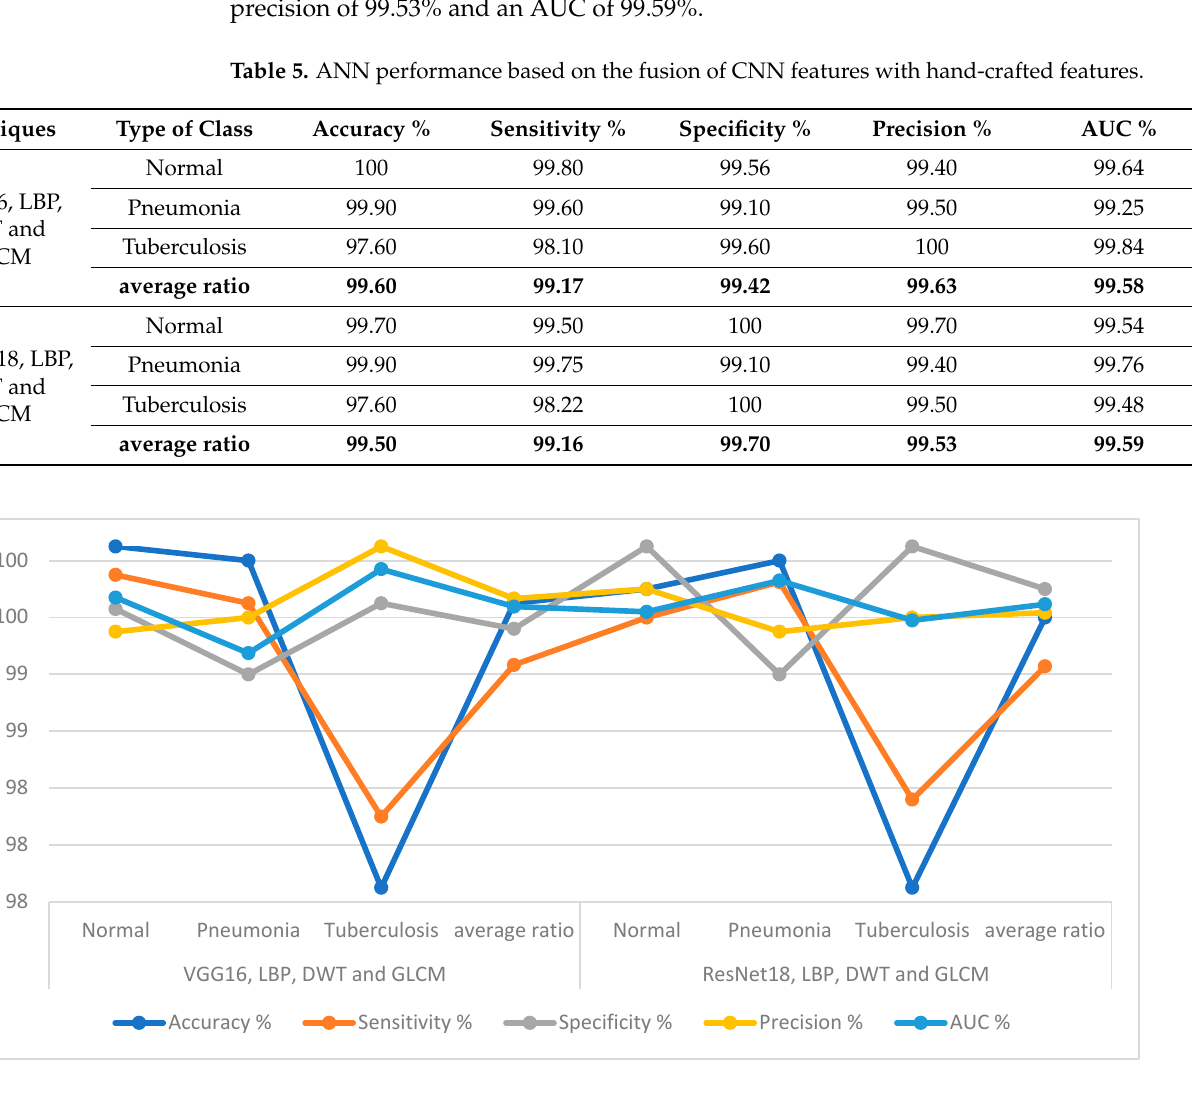
Figure 15. ANN achievement based on fusing the features of CNN with hand ‐ crafted features for diagnosing the X ‐ rays of the pneumonia and tuberculosis data set.